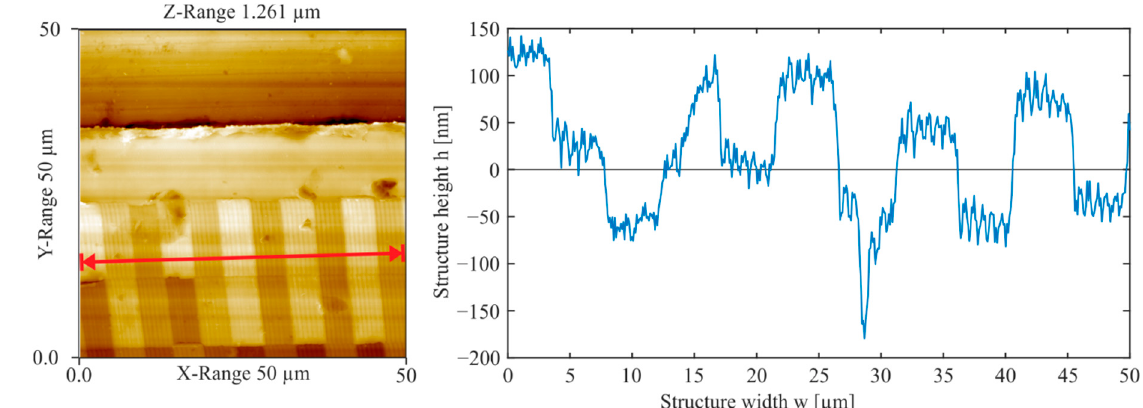
Figure 5. Atomic force microscopic measurement and cross section of the replication of a diffractive structured mold insert.